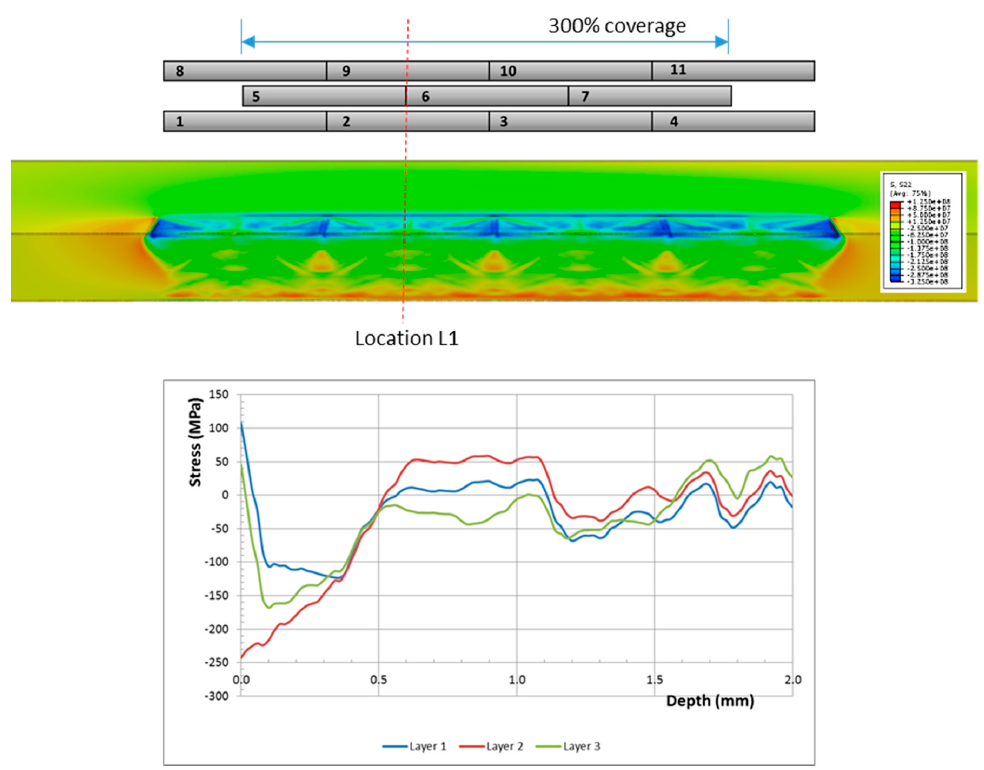
Figure 8. Effect of peen layering on predicted in-plane residual stress in thin sections. Stresses were extracted from the FEA model at Location L1 after one, two, and three layers of peening. Metals 2019 , 9 , x FOR PEER REVIEW